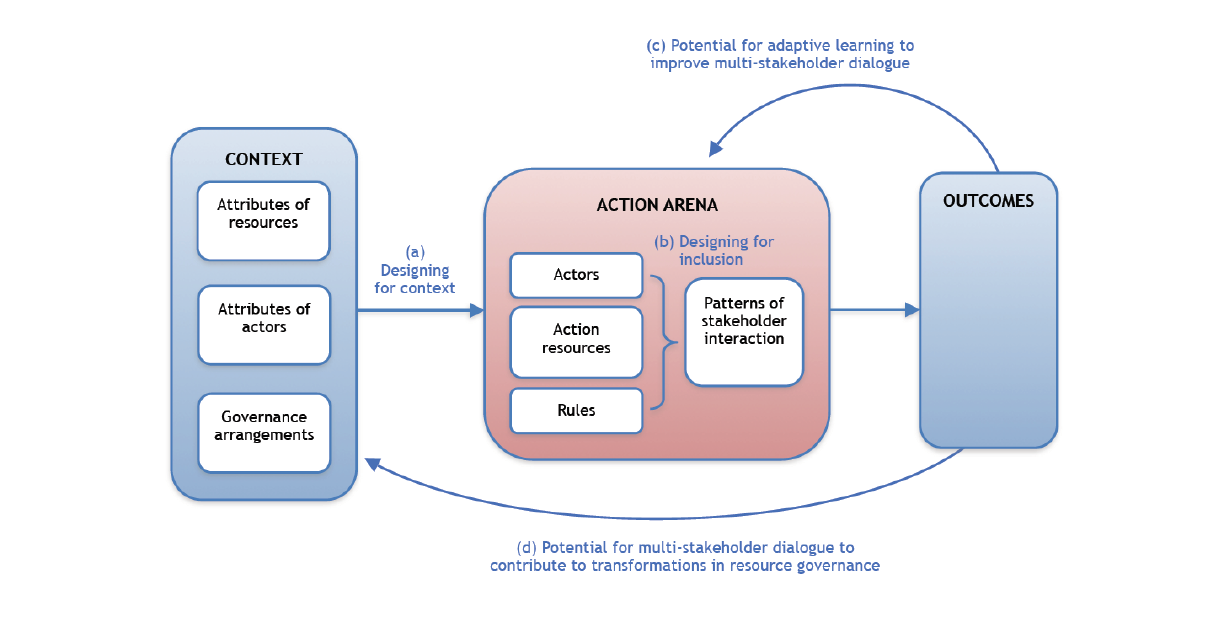
Fig. 1. Dynamics of multistakeholder dialogue and adaptive learning in natural resource governance. Lowercase letters denote the focus of analysis addressing particular linkages. Adapted from Di Gregorio et al. (2008) and Ostrom